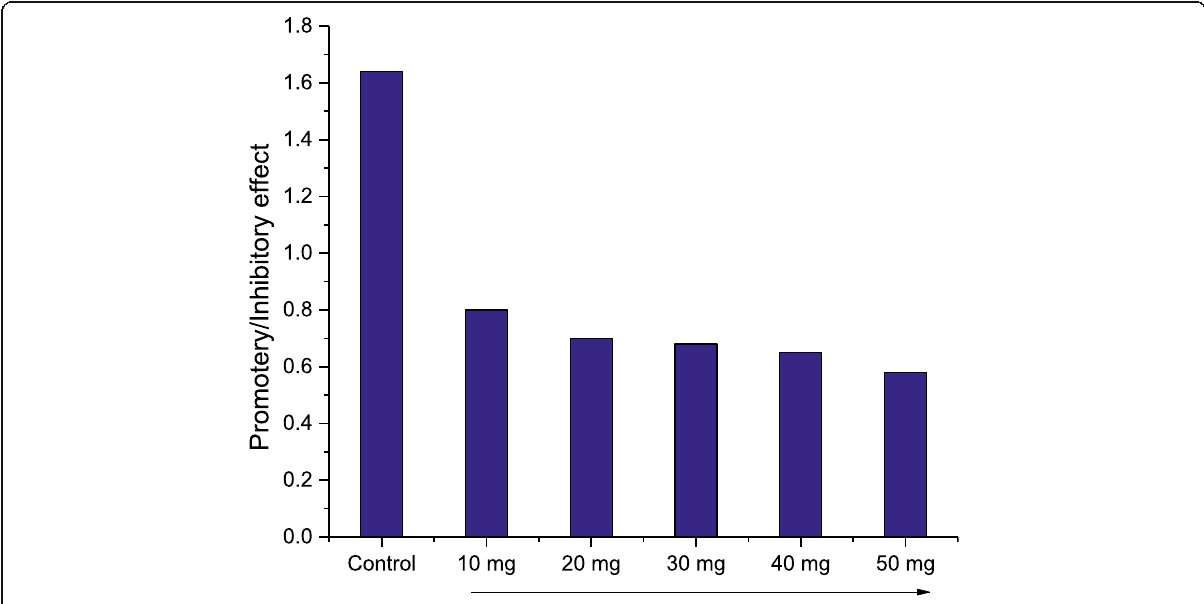
Fig. 4 Promotery/Inhibitory effect of Brushite crystals